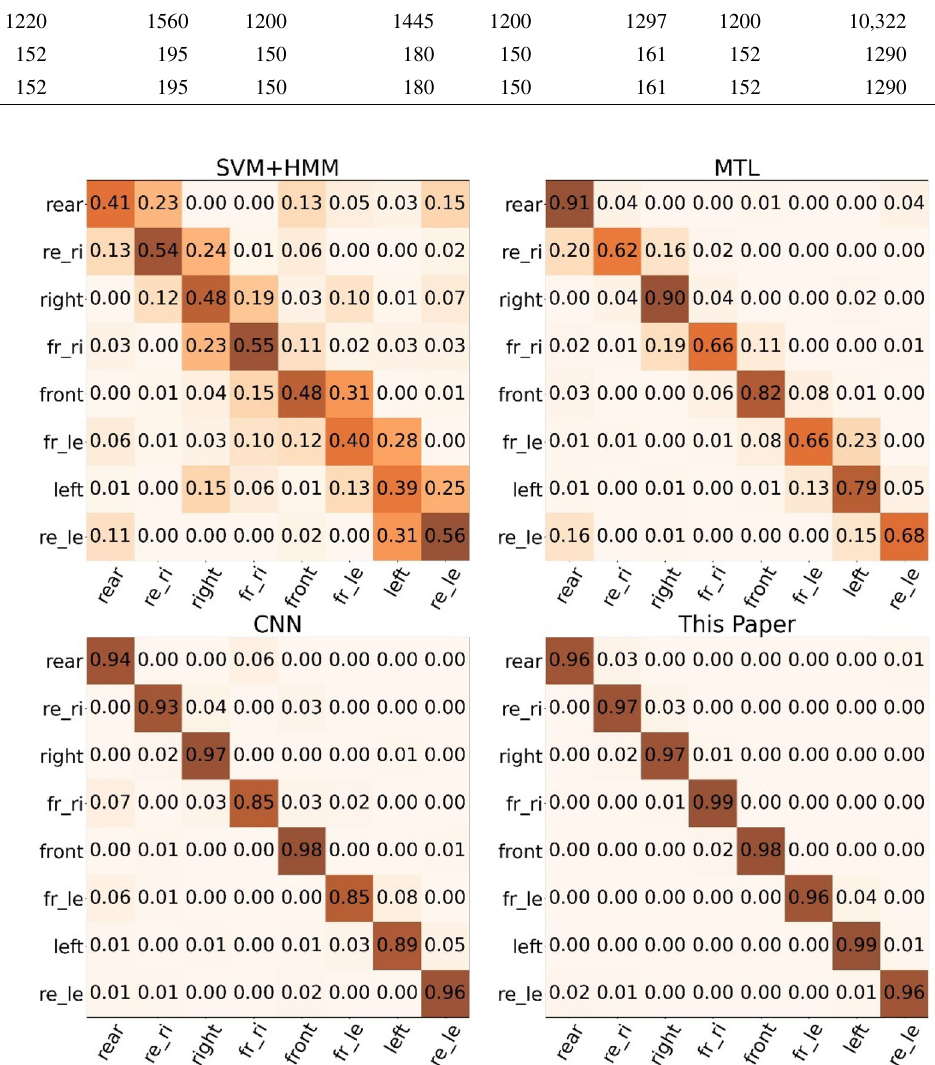
Table 3 Number of images in each class of the original PDC augmented data set Data set